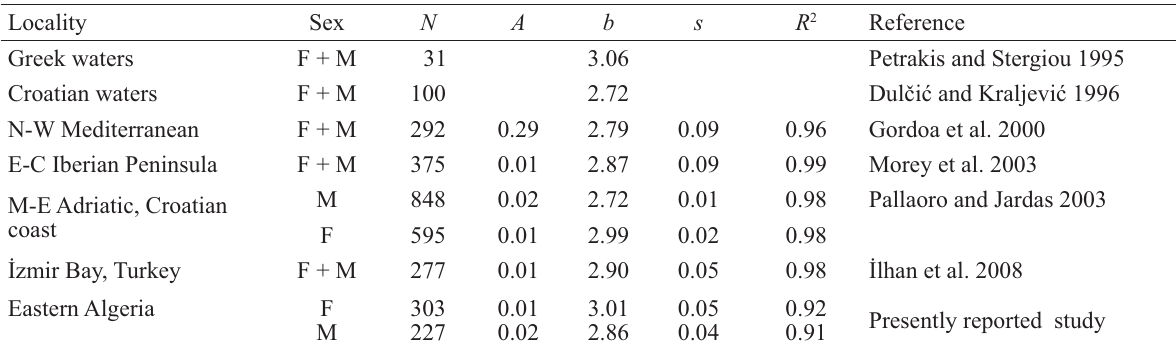
Parameters of the length–weight relation of peacock wrasse, Symphodus tinca , from different areas